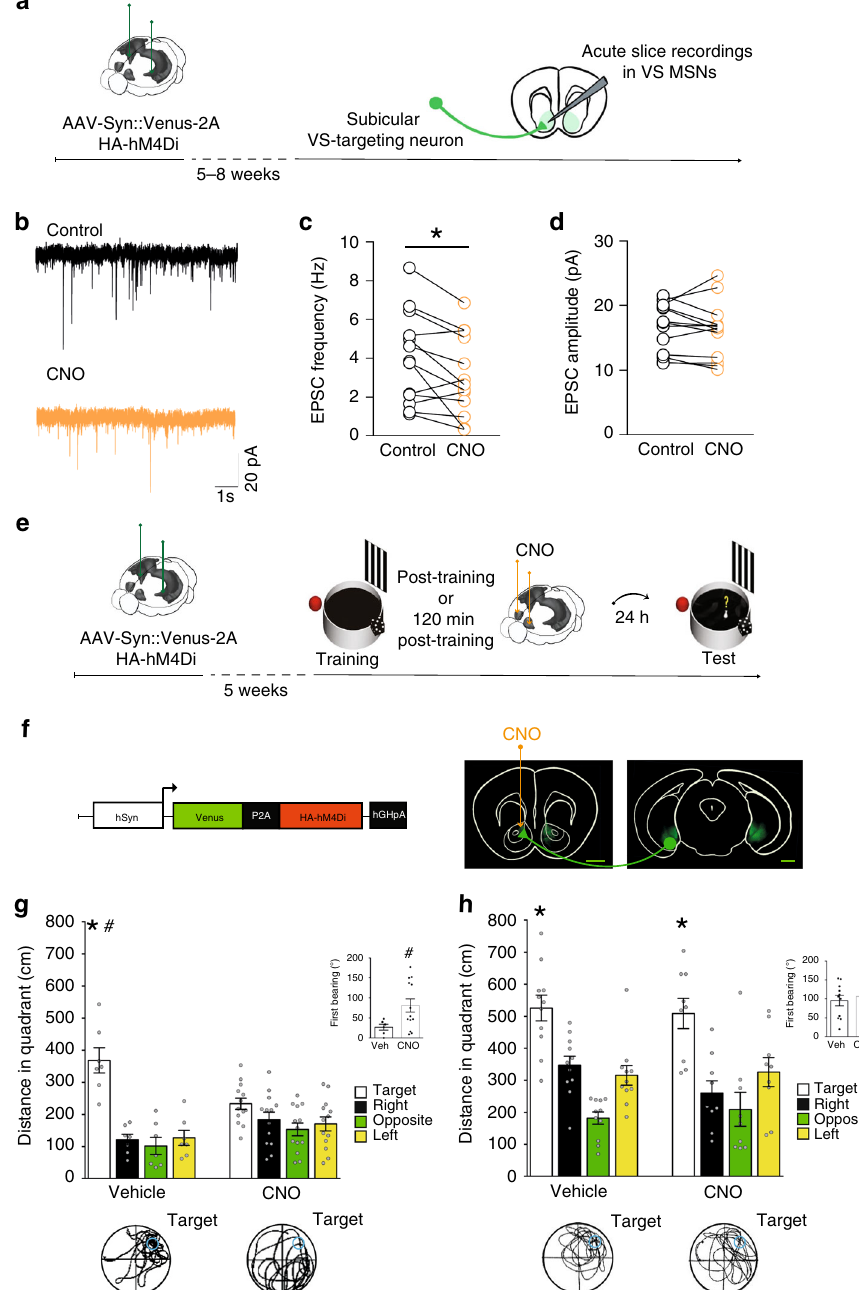
Fig. 4 Inhibition of vSUB terminals targeting the VS impairs spatial memory consolidation. a Schematic of the ex vivo electrophysiology DREADDs experiment. b Representative traces from VS MSNs showing sEPSCs in control conditions (black) and under CNO (orange) c Scatter plot graph summarizing sEPSC frequency in control conditions (black) and under CNO (orange) ( n = 13 cells/6 mice; t 12 = 2.8, p = 0.015; paired t -test). d CNO did not change the sEPSCs amplitude ( p = 0.38; paired t- test). e Schematic of the behavioral DREADDs experiment. f Schematic of AAV expressing Venus and the HA-tagged hM4D i under the h-Synapsyn (Syn) promoter. Representative coronal sections from HPC and VS. Scale bars: 1 mm. g Mice infected in the vSUB with the AAV and injected post-training with CNO (10 mM) in the VS showed impaired performance on the probe test. Histograms represent the mean of distance traveled in each quadrant for vehicle ( n = 7) and CNO ( n = 13) injected groups (repeated measures ANOVA of quadrant preference F = 22.976, p = 0.0001; treatment F = 0.085, p = 0.7735; quadrant preference × treatment F = 8.019, p = 0.0002). The insert shows fi rst 3,54 1,18 3,54 bearing of mice in the two groups ( t 17 = 3.450; p = 0.0031; unpaired t test). Bottom panels: representative path from vehicle and CNO animals. h Mice bilaterally infected in the vSUB and injected 120 min post-training with CNO (10 mM) in the VS showed no impairment in the performance. Histograms represent the mean of distance traveled in each quadrant for vehicle ( n = 11) and CNO ( n = 9) injected groups (repeated measures ANOVA of quadrant preference F 3,54 = 24.6954, p < 0.0001; treatment F 1,18 = 0.4137, p = 0.3721; quadrant preference × treatment F 3,54 = 0.8742, p = 0.46022). The insert shows fi rst bearing of mice in the two groups ( t 18 = 0.5077; p = 0.6178; unpaired t- test). Bottom panels: representative path from vehicle and CNO animals. Histograms represent mean ± SEM. # p < 0.05 target vs target (between groups); * p < 0.05 target quadrant vs right, opposite, left (within group, Tukey). Bottom panels: representative probe-trial. MWM images modi fi ed from ref. 9 ; Image credit for brains schematics: Allen